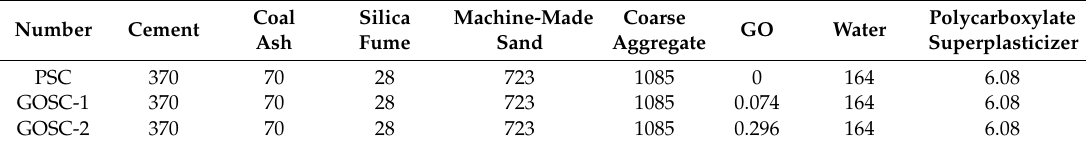
Table 6. Experiment number and mixture ratio (kg/m 3 ).